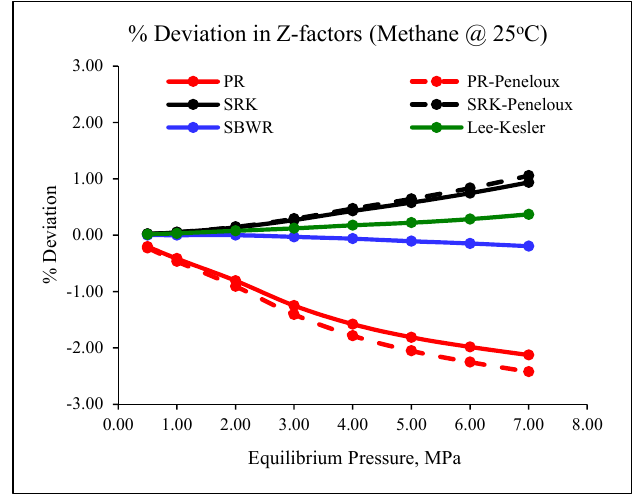
Figure 3. Example of variations in gas compressibility factor of methane at 25 °C.